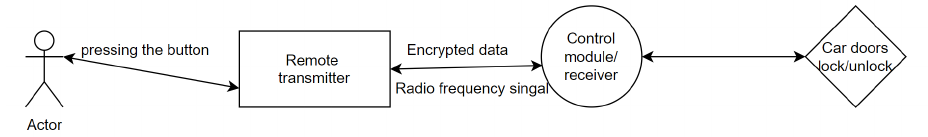
Figure 9. Representation Model of Functionality for Key